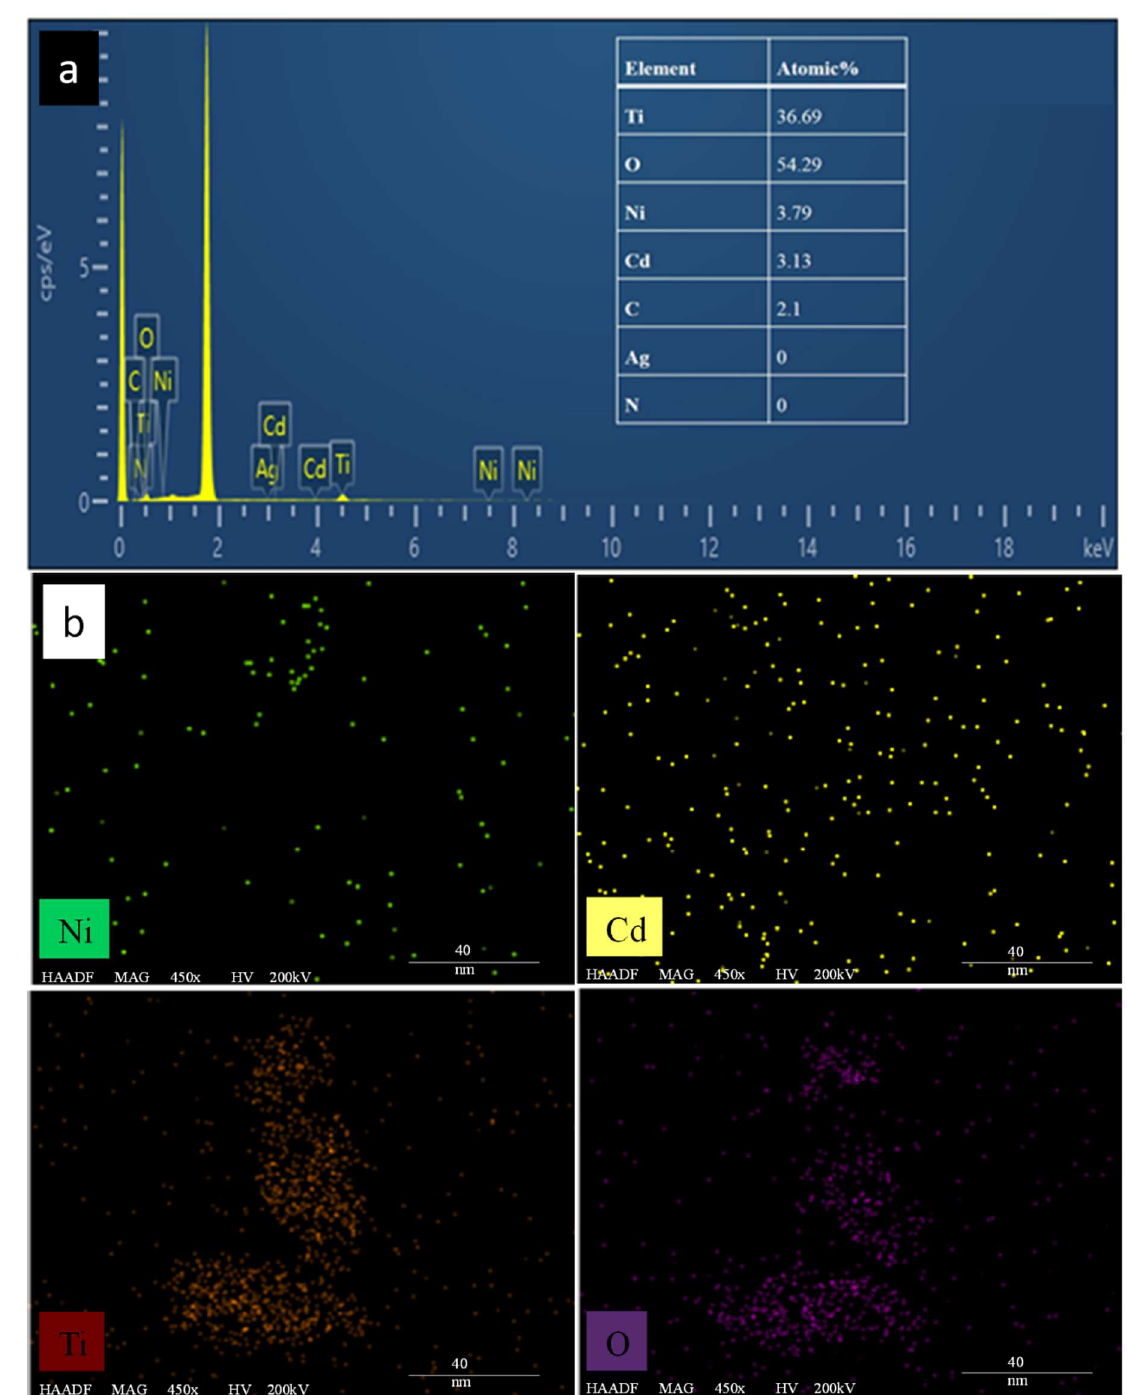
Figure 5. ( a ) EDX spectra and ( b ) mapping of the ternary NiCdTiO 2 nanocomposite.